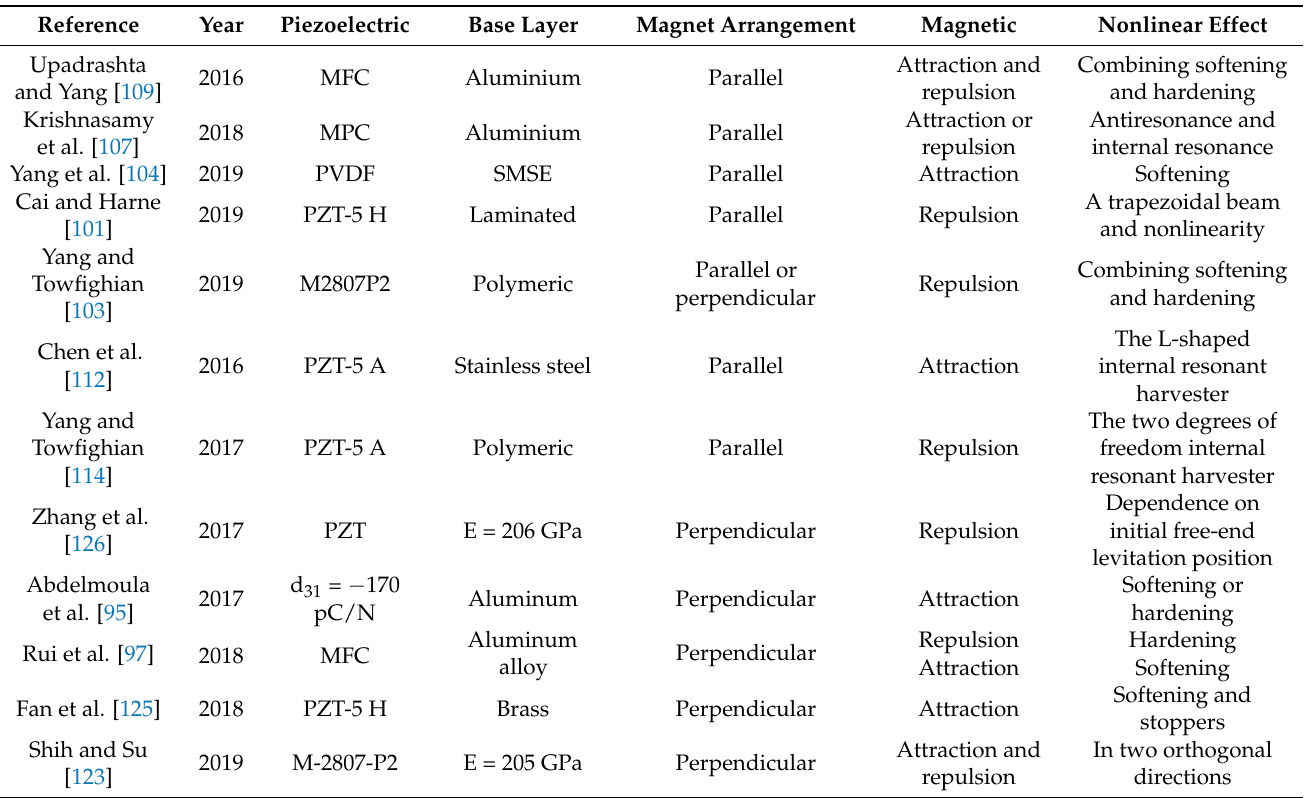
Table 1. Characteristics of some existing monostable-type piezoelectric